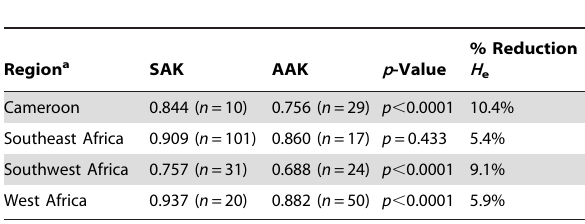
Table 2. Expected heterozygosity H e at the 0.8 kb microsatellite locus linked to SAK and AAK single-mutant alleles by geographical